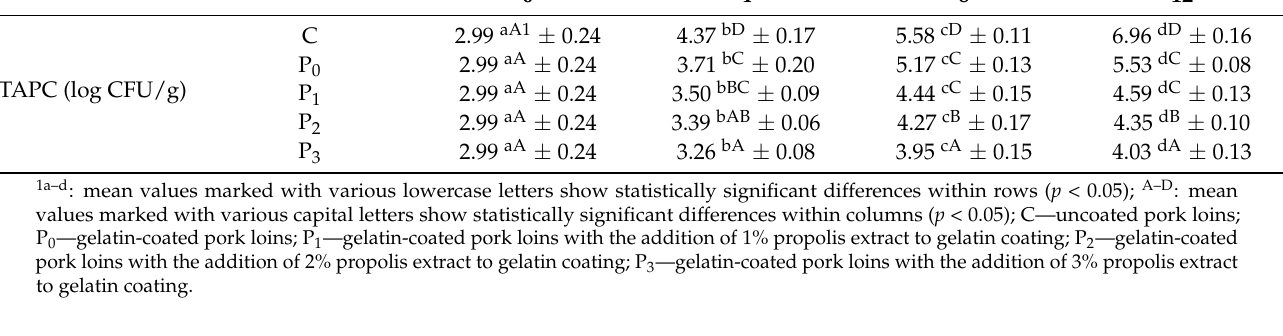
Table 4. The effect of the applied coatings on chemical parameters of pork loins during storage.